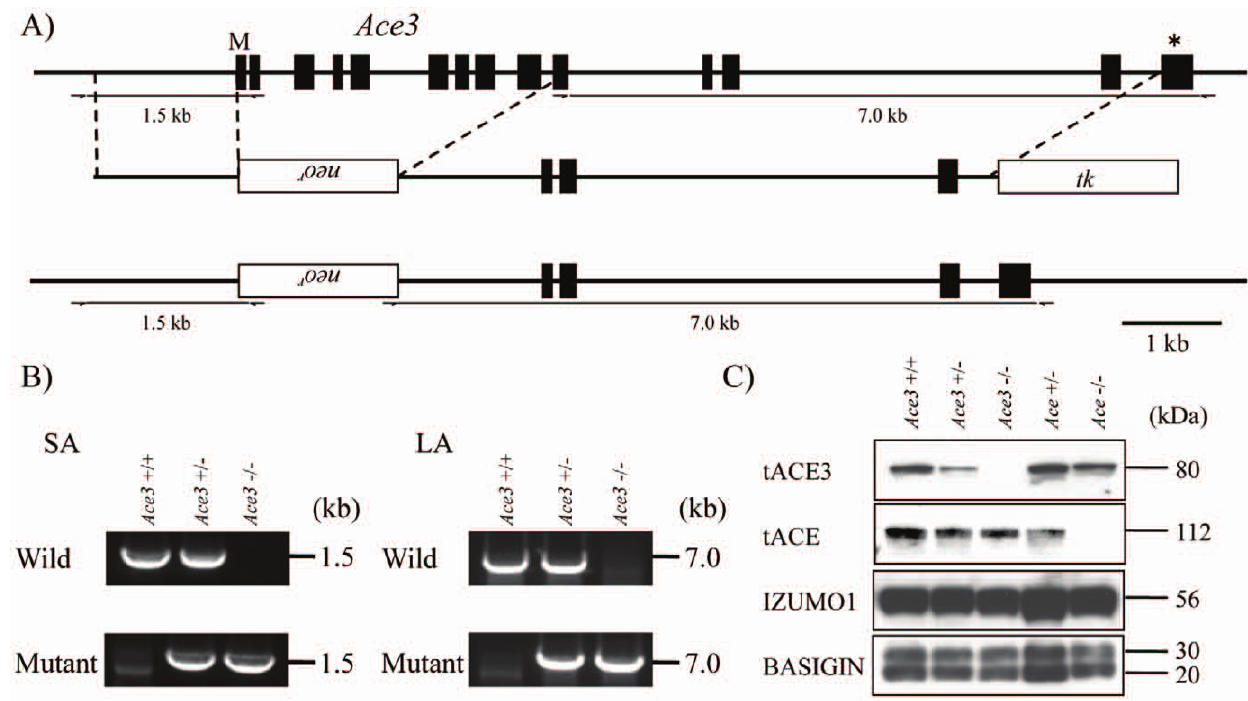
Figure 3. Targeted disruption of Ace3 gene. (A) Complete structures of the wild-type mouse Ace3 allele . Exons and introns are represented by boxes and horizontal lines, respectively. For the targeted disruption of mouse Ace3 allele, the first 9 exons (closed boxes) were replaced by the neomycin-resistant gene (Neo r ). A herpes simplex virus thymidine kinase gene (tk) was introduced into the targeting construct for negative control. (B) Genotyping of tail tip DNA by PCR amplification with primers indicated in the figure. (C) Western blotting analysis of sperm lysates from wild-type, Ace3 + / 2 , Ace3 2 / 2 , Ace + / 2 and Ace 2 / 2 mice.